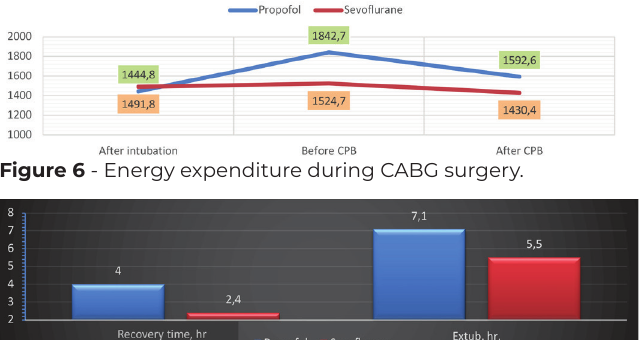
Figure 7 - Recovery and extubation times in both patient groups.